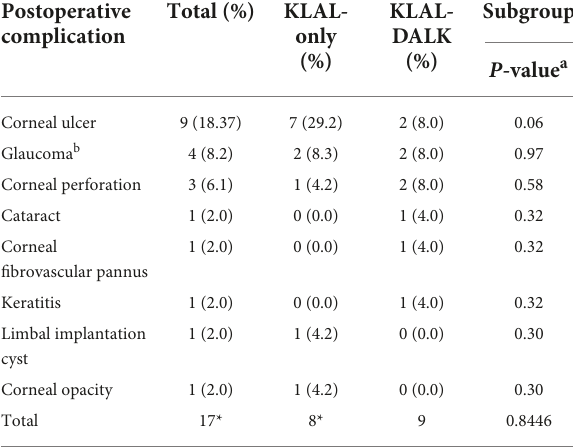
TABLE 2 The incidence of complications in the KLAL-only group and KLAL-DALK